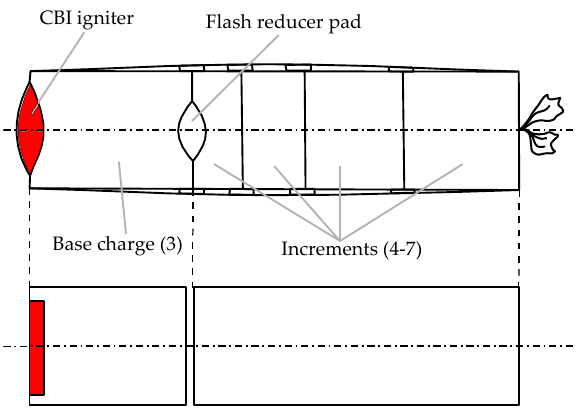
Figure 1. Outline of M4A2 charge assembly (top) and modeled geometry (bottom).